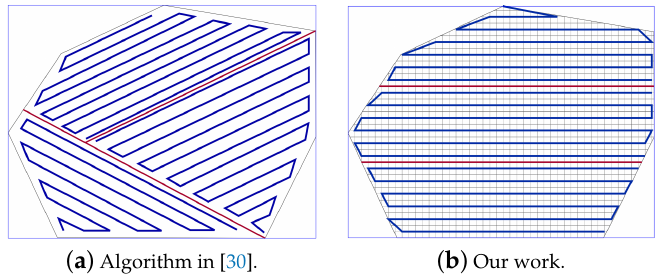
Figure 21. The paths generated by the algorithms in [30] and by our